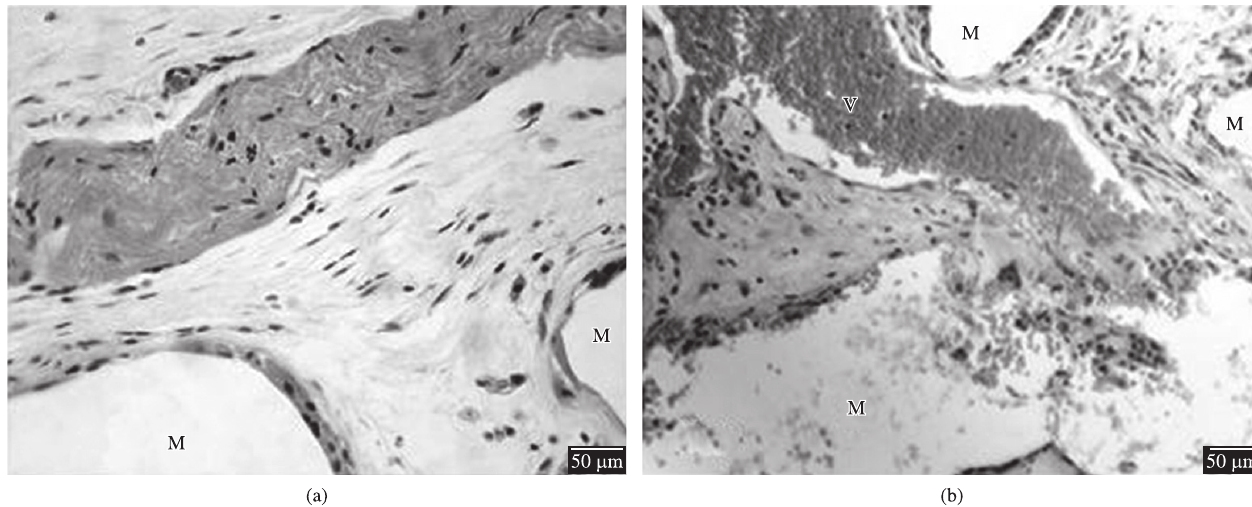
Figure 4. Histological sections, stained with HE, 60 days after grafting with HA (a) or ZnHA (b). (M) indicates the grafted area. (V) indicates blood vessels.